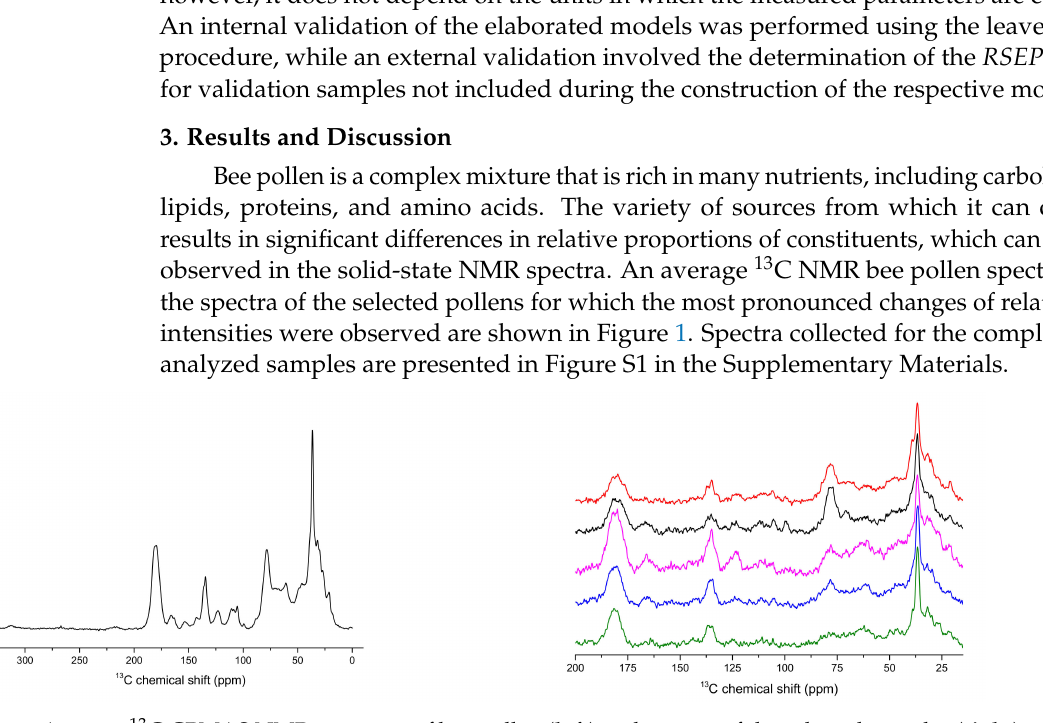
Figure 1. Average 13 C CPMAS NMR spectrum of bee pollen ( left ) and spectra of the selected samples ( right